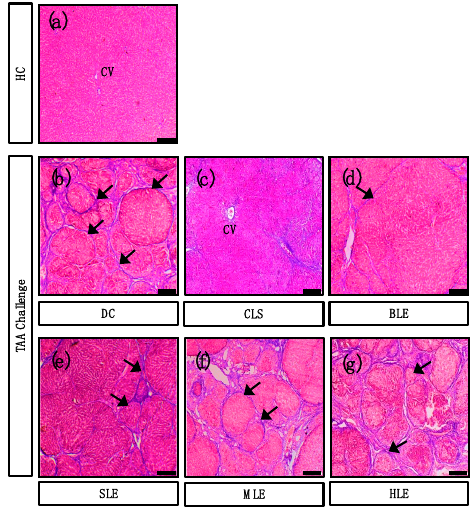
Figure 5. Aqueous extracts (CLS and BLE) showed an anti-fibrotic effect against TAA-induced liver cirrhosis. Histopathology of (stained with Masson’s trichrome) HC, DC and different leaves extracts of O. octandra treated CLS, BLE and SLE) livers at 15 weeks. ( a ) In the HC livers, collagen fibers were mainly seen in the vascular wall. ( b ) Increased collagen deposition in the thickened fibrous bridges was seen in DC. ( c ) A small amount of collagen was detected mainly in the periportal and centrilobular areas in livers treated with CLS. ( d ) Livers treated with BLE showed a few collagen deposits as thin fibrous bridges. ( e – g ) Increased amounts of collagen with thickened fibrous bridges were observed in livers treated with SLE, MLE and HLE. CV, central vein. Arrows indicate collagen depositions. Bar = 100 µm.